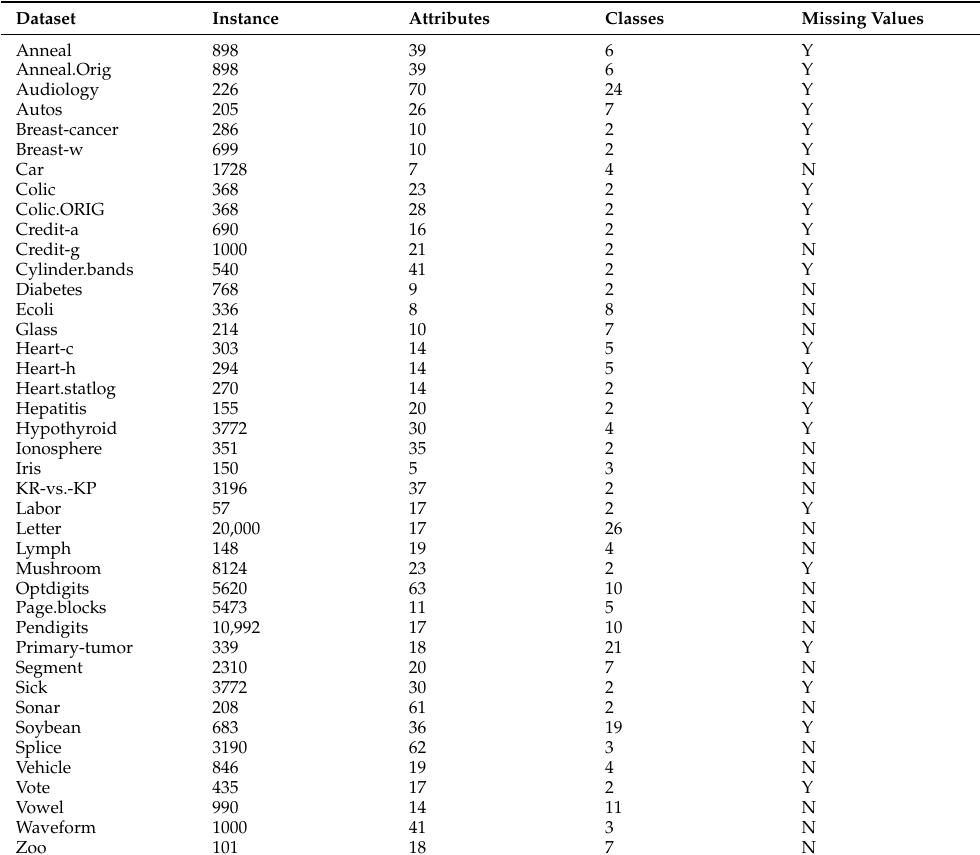
Table 2. UCI general dataset